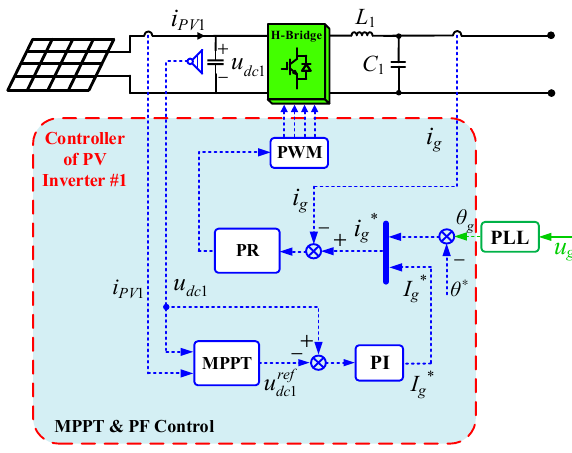
Figure 3. Control diagram of inverter#1.